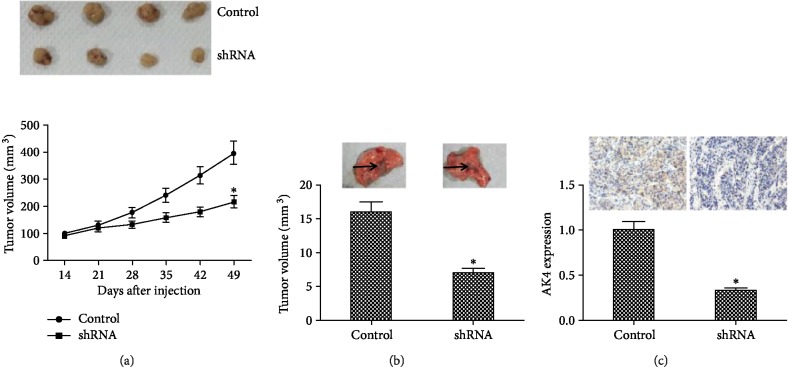
AK4 induces tumor growth and metastasis of HER2-positive breast cancer in mice. (a) MCF7 cells infected with control or AK4 shRNA lentivirus were subcutaneously implanted into nude mice. After 2 weeks, tumors were isolated, and the volume of tumor was measured every 7 days (n = 5 in each group). Tumor growth curves were calculated and evaluated based on the average volume of 5 tumors in AK4 knockdown and control groups. (b) MCF7 cells infected with control or AK4 shRNA lentivirus were implanted into the caudal vein of nude mice. After 8 weeks, tumors were isolated from mice in each group and weighted (n = 5 for each group). (c) IHC assays showed the expression levels of AK4 in control or AK4 ablation tumors isolated from mice. Results are presented as mean ± SD, ∗P < 0.05.